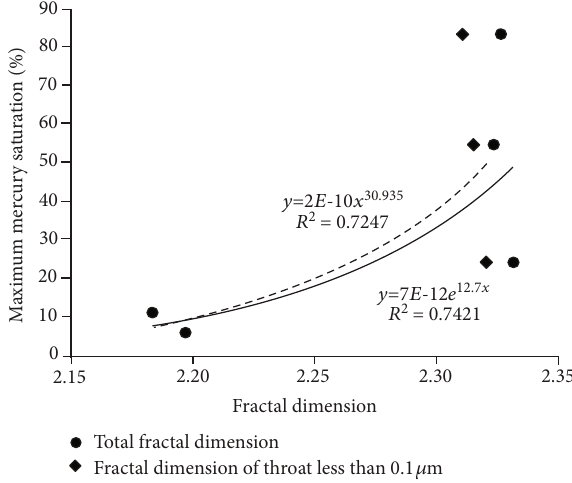
Figure 4: Relationship between fractal dimension of pore throats and maximum mercury